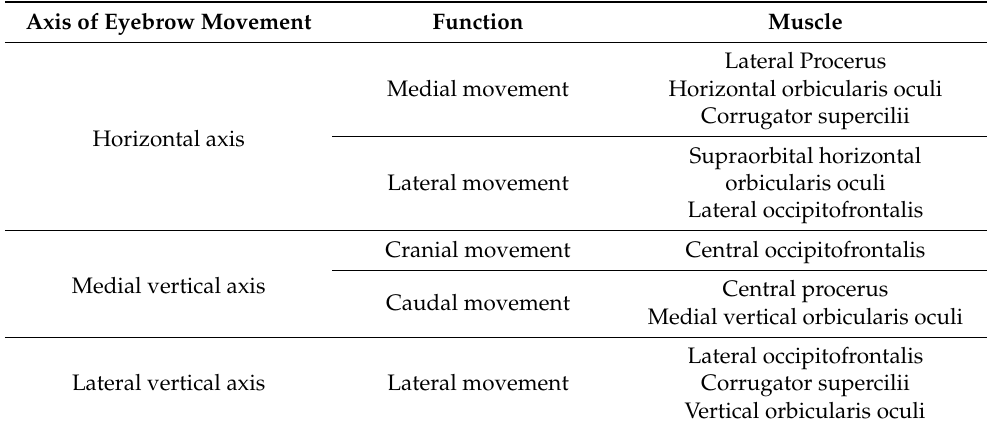
Table 1. An overview of the three axes of eyebrow movement and the function of each perior- bital muscle. Axis of Eyebrow Movement Function Muscle Lateral Medial movement Horizontal axis